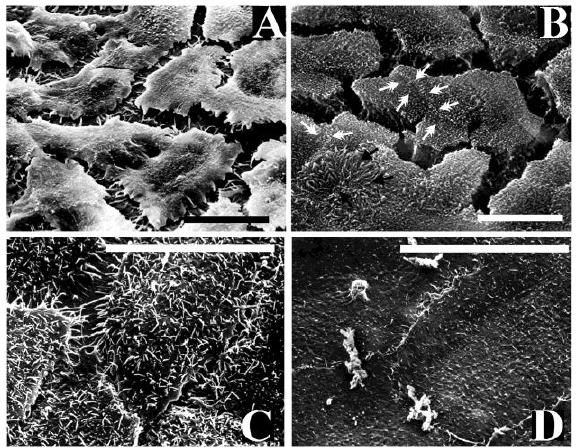
FIGURE 4. Differentiation of cells treated with NAC. Transmission electron micrographs of control (A) and of NAC-treated Caco-2 cells (B,C). Arrows in (B) and (C) point to some brush-border microvilli; open arrows in (C) point to secretory vesicles. (D) Confocal fluorescence micrographs of intracellular secretory vesicles in Caco-2 cells – Golgi apparatus and endoplasmic reticulum – labeled by TRITC- conjugated wheat germ agglutinin. Longitudinal sectioning along the x/z plane of control (top) and NAC-treated (bottom) cells allows a clear visualization of the apical distribution and of the increased amount of secretory vesicles after NAC treatment, as well as a relevant increase in thickness, indicating a differentiated function and morphology. Intensity color scale on the right. (E) Scanning electron micrograph of initial stage of cornified envelope in NHEK, with an enucleated cell (arrows). (F) Confocal fluorescence micrograph in NHEK of an actin-vinculin (green and red, respectively) double-stained cornified cell showing that actin microfilaments participate in the enucleation process. Bars: 1 μm in (A,B); 300 nm in (C); 10 μm in (D); 100 μm in (E); 25 μm in (F). Redrawn from Parasassi et